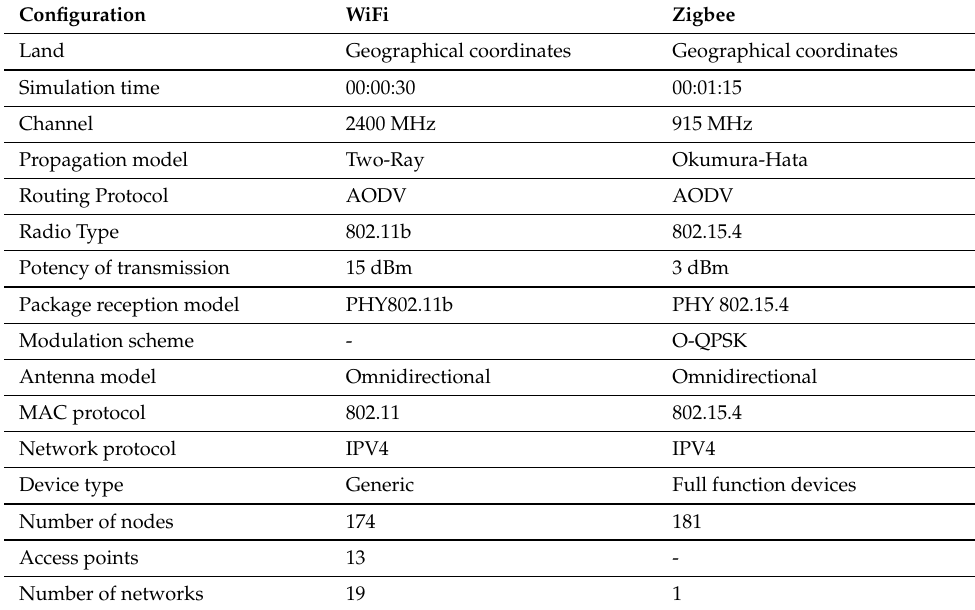
Table 4. Configuration summary of the scenarios to